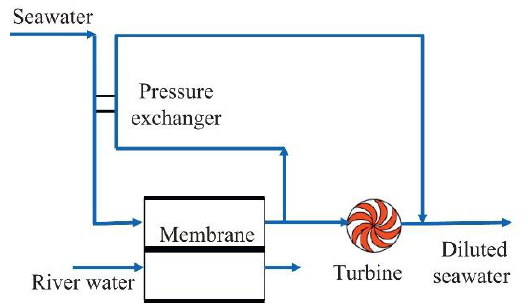
Figure 2. Operational principle of the pressure retarded osmosis (PRO) process. Reproduced with permission from [17]. Copyright Elsevier, 2013.